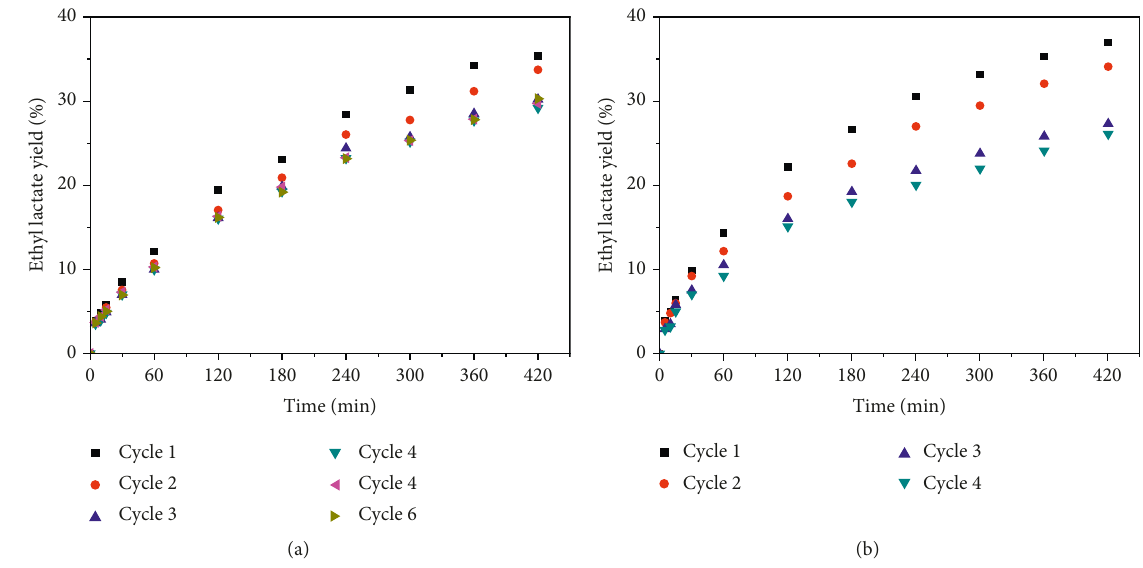
Figure 5: Test of recycled GO/AC (a) and sulfonated biochar (b) catalysts.